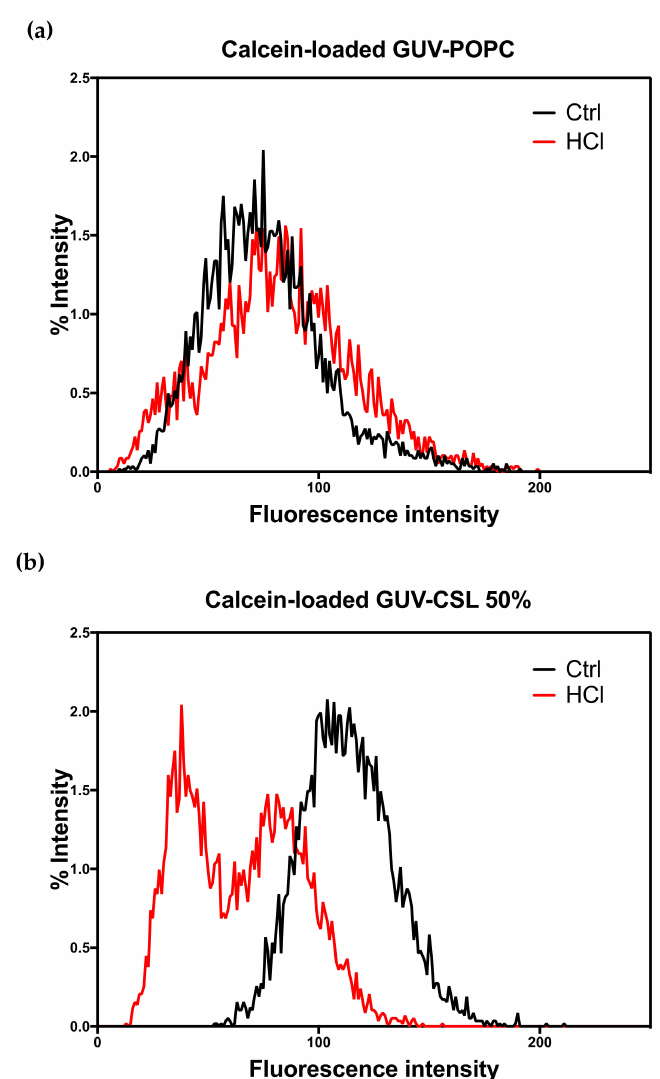
Figure 2. Overall calcein fluorescence intensity in GUVs before and after acidification (pH 6.8 and 4.8). ( a ) Calcein loaded GUV-POPC and ( b ) calcein-loaded GUV-CSL